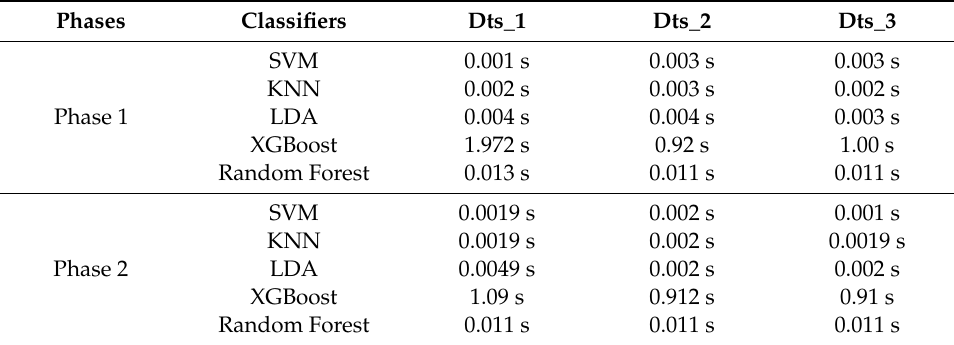
Table 17. Summary of the achieved time results for all binary classifiers.